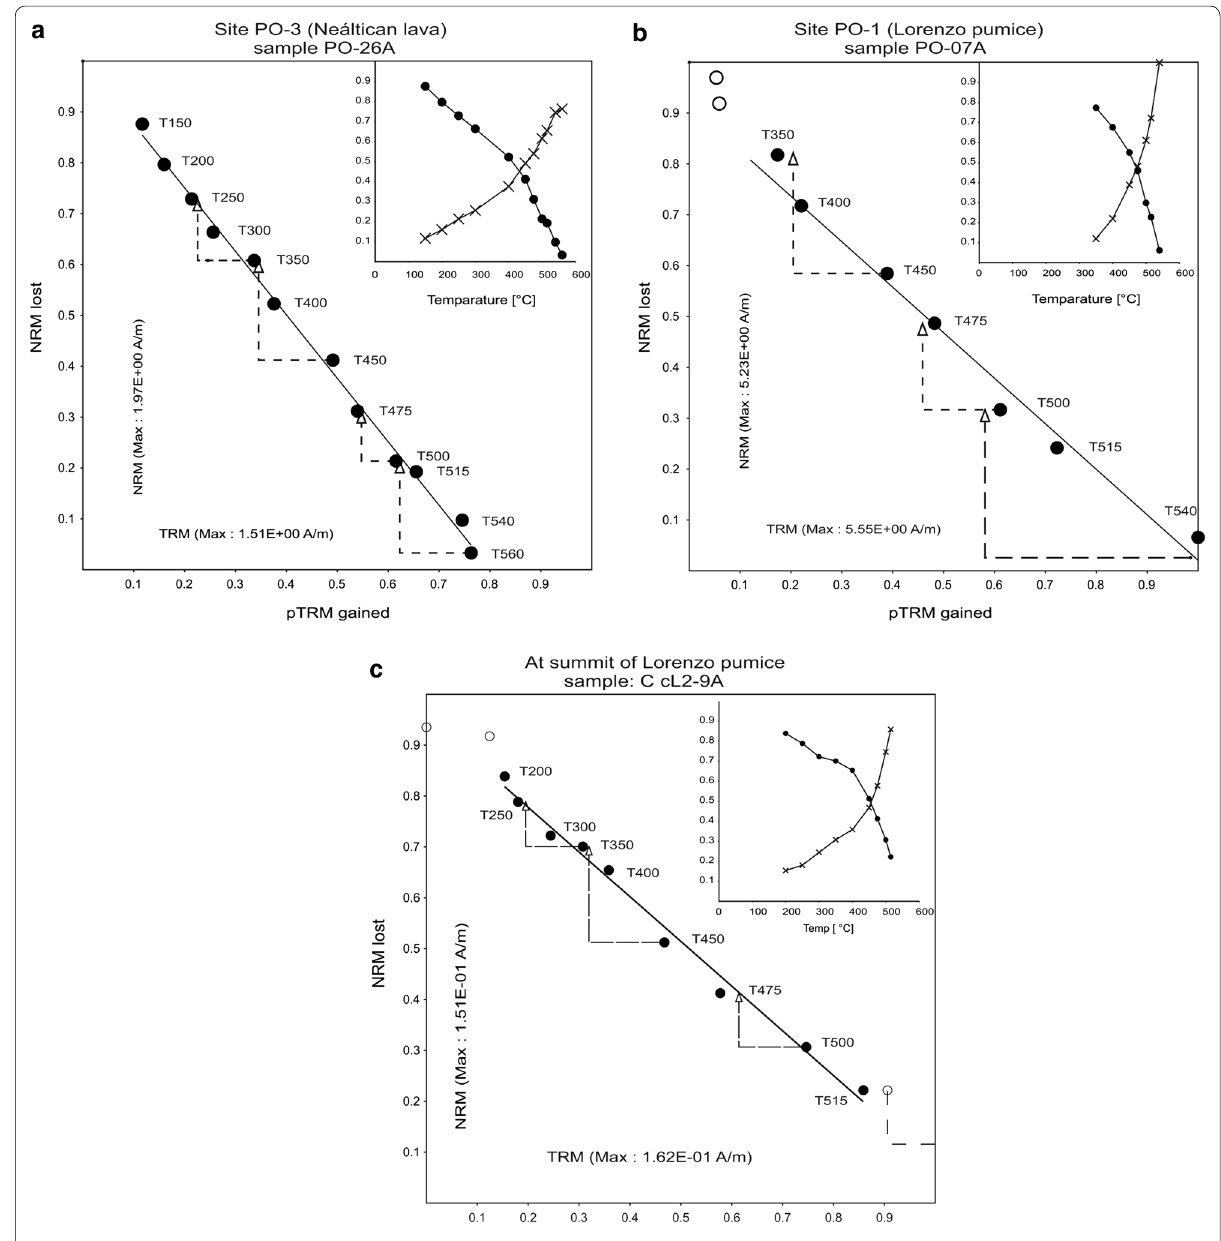
Fig. 16 a – c Representative Thellier–Coe NRM lost versus pTRM gained (Arai) plots for the different studied flows. Neáltica lava ( a ), Lorenzo Pumice flow ( b ) and summit of Lorenzo Pumice ( c ). Filled circles correspond to data points obtained at each double heating step used for the best fit regression line. Open circles correspond to data points not considered for the best fit calculation. Inset shows the NRM lost (pTRM gain) versus temperature at each step. Triangles represent the pTRM